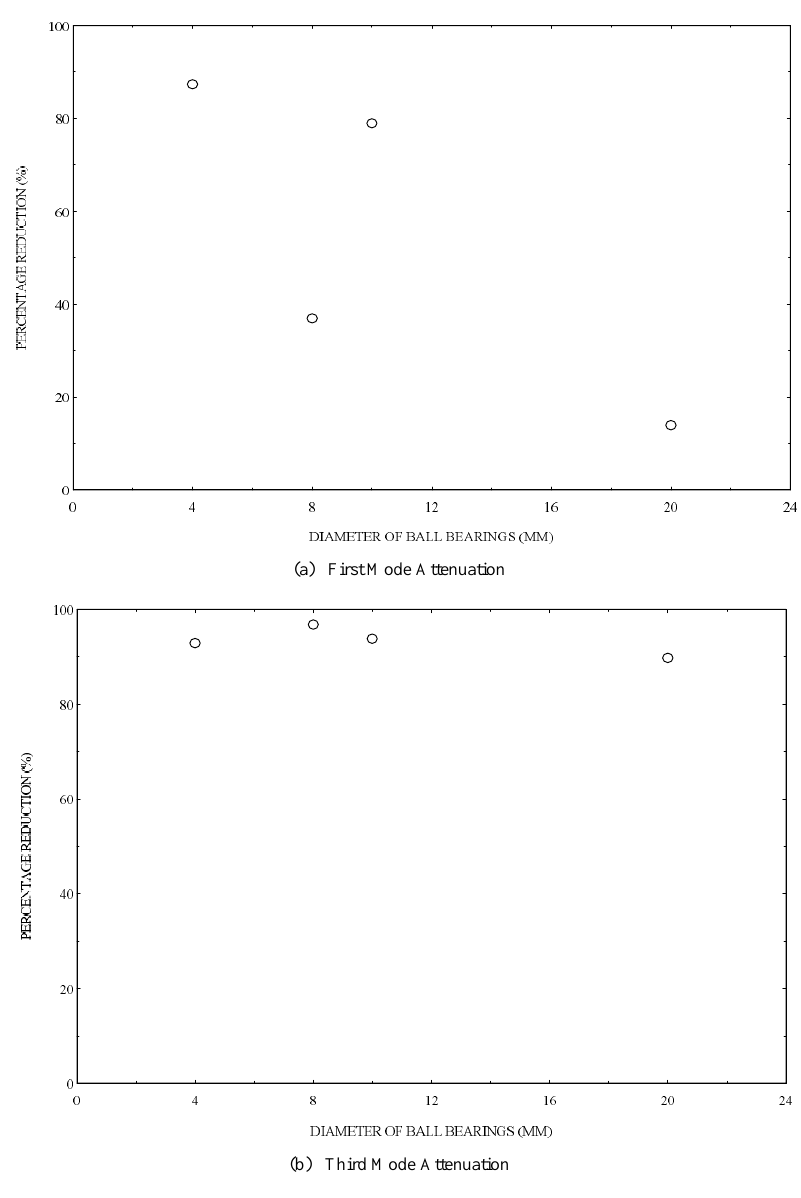
Fig. 4. Variation of vibration reduction with size of ball